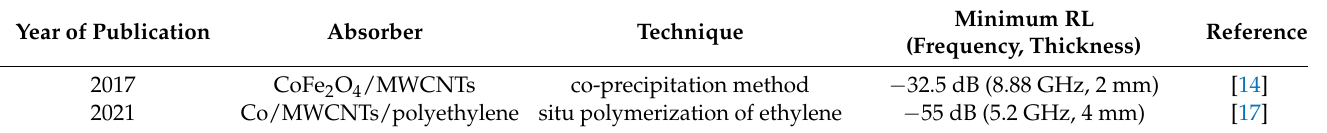
Table 1. Summary of research status of MWCNTs-based composite absorbing